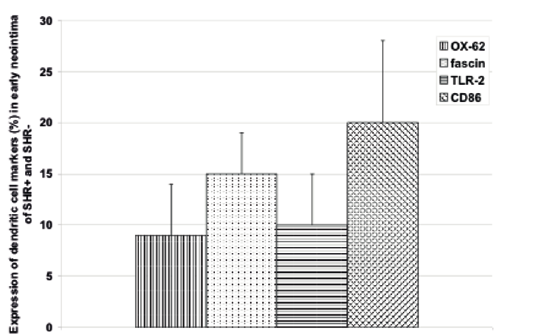
Figure 3. Bar graph demonstrating total cell number in neointima with time after balloon angioplasty in spontaneously hyper- tensive rats with (SHR+) and without ACE inhibitor (SHR-).